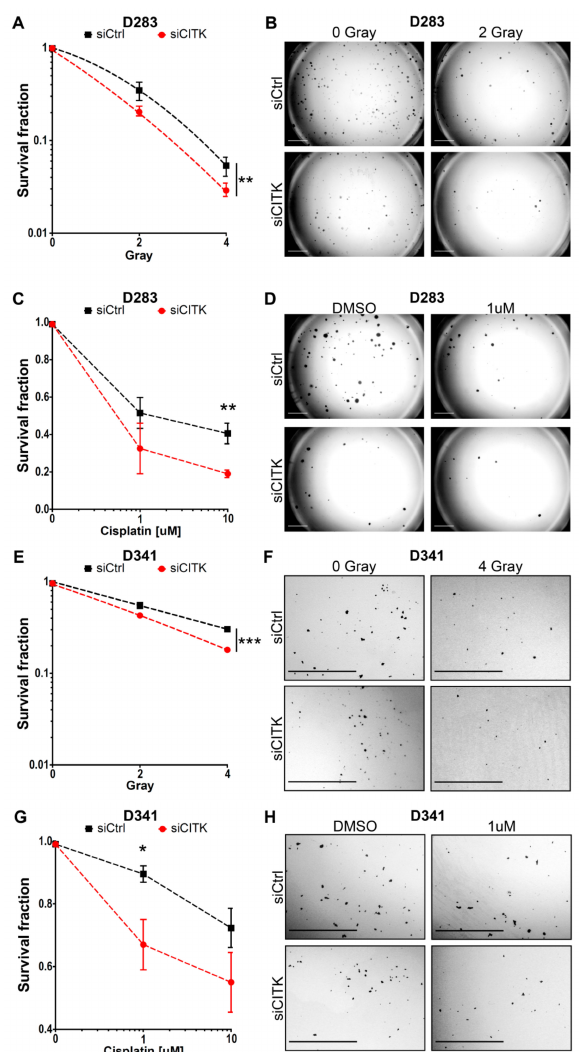
Figure 5. CITK knockdown potentiates the e ff ects of radiation and cisplatin treatment in G3 / G4 MB cell lines. ( A ) D283 cells were transfected with nontargeting or CITK-specific siRNA and, after 72 h, irradiated at the indicated doses and plated at low density (see methods for the details). After 10 days, the colonies were fixed and stained with crystal violet. The siCtrl and siCITK curves were obtained by fitting the values into a nonlinear regression curve and compared with Extra sum-of-squares F test. ( B ) Phase contrast images of representative fields of D283 transfected with siCtrl or siCITK 10 days after irradiation. ( C ) D283 cells were plated and transfected with nontargeting or CITK-specific siRNA. After 72 h, cells were treated with 1 or 10 µ M of cisplatin for 1 h. Cells were then washed, and fresh medium was added. Colonies were stained after 10 days with crystal violet. ( D ) Phase contrast images of representative fields of D283 transfected with siCtrl or siCITK, 10 days after treatment with 1 µ M of cisplatin. ( E ) D341 cells were transfected with nontargeting or CITK-specific siRNA and after 72 h irradiated at the indicated doses. After 14 days, the colonies were fixed and stained with crystal violet. The curves were obtained and analyzed as in ( A ). ( F ) Phase contrast images of representative fields of D341 transfected with siCtrl or siCITK 14 days after irradiation. ( G ) D341 cells were plated and transfected with nontargeting or CITK-specific siRNA. After 72 h, cells were treated with 1 or 10 µ M of cisplatin for 1 hour. Cells were then washed, and fresh medium was added. Colonies were stained after 14 days, with crystal violet. ( H ) Phase contrast images of representative fields of D341 transfected with siCtrl or siCITK 14 days after treatment with 1 µ M of cisplatin. All quantifications were based on five independent biological replicates. Error bars, SEM. *, p < 0.05; **, p < 0.01; ***, p < 0.001, two-tailed Student’s t